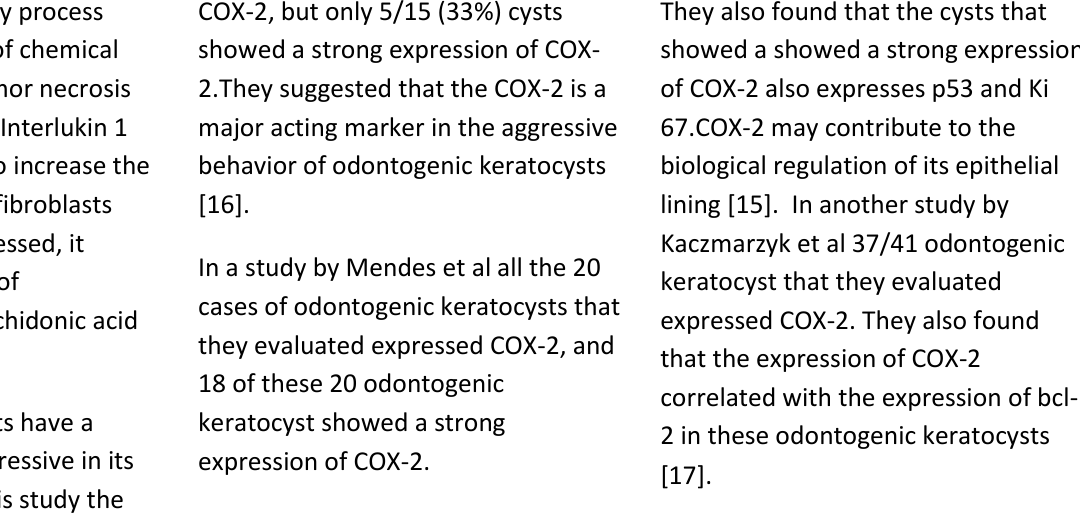
Table 3 . The association between the Odontogenic cysts and the expression (Total Score) of COX-2